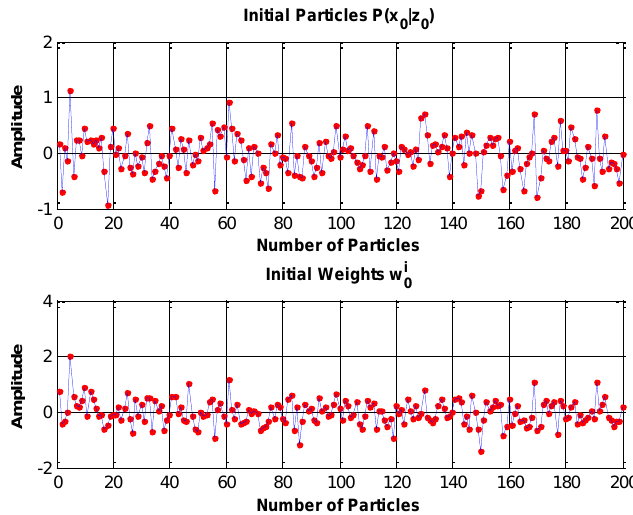
Figure 6. Initial particles p(x 0 |z 0 ) and initial weights w 0i for the PF. The initial particles and weights of attitude errors (δϕ, δθ, δψ) , velocity errors (δV N , δV E , δV D ) , and position errors (δφ, δλ, δh) are identical because the initial parameters (initial states and initial estimation errors) to evaluate the initial particles and initial weights are the same.